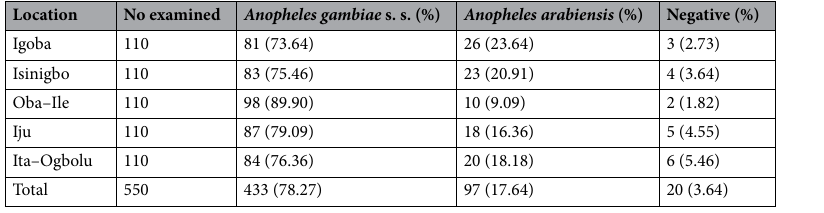
Table 1. Distribution of molecular identified Anopheles gambiae complex in the study area. Chi-square ( χ 2 ) = 12.18; df = 4; P = 0.14 (P >